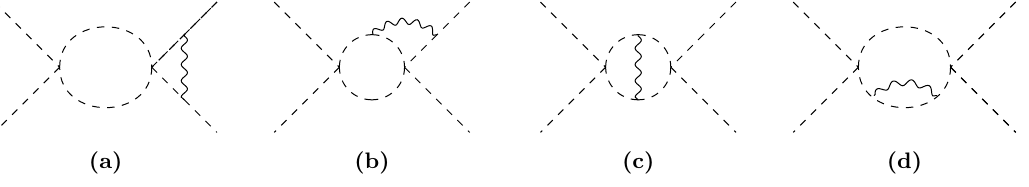
2 S 2Λ g 2 , − 6Λ 2 g abcd